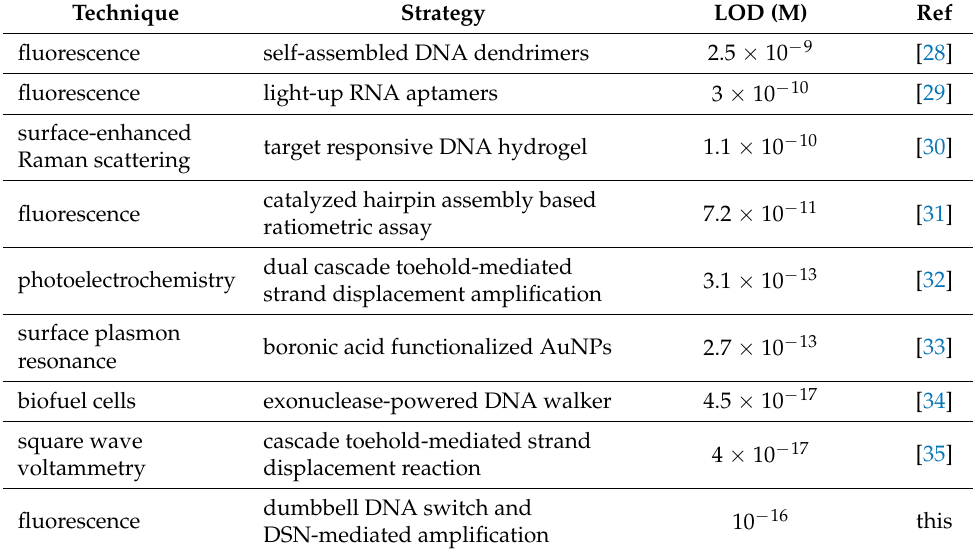
Table 2. Comparison of the analytical performances of recent miRNA